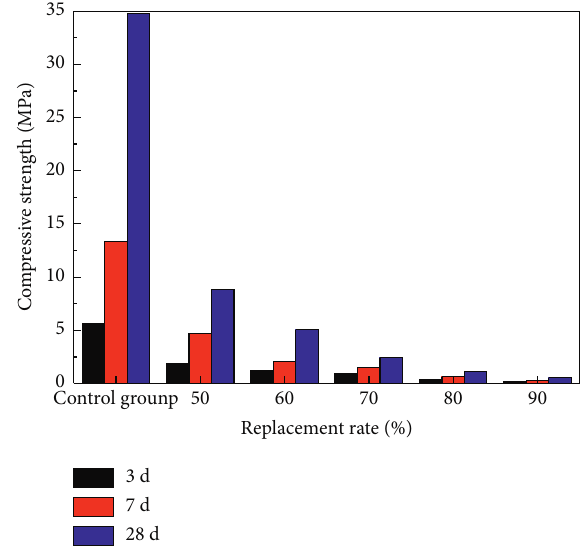
Figure 8: Compressive strength at different substitution rates.